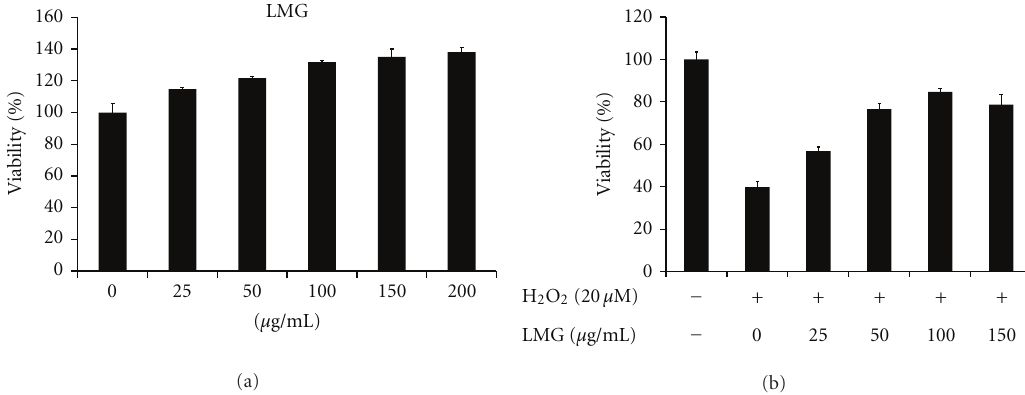
Figure 5: Protective abilities of LMG against H 2 O 2 -induced cytotoxicity in RAW264.7 cells. (a) MTT assay evaluated the cytotoxicity of LMG to RAW264.7 cells. Cells were treated with LMG (at 0, 25, 50, 100, 150, and 200 μ g/mL) for 24h. Results are presented as means ± SD for n = 5 replicates. (b) The protective ability of LMG from H 2 O 2 -induced cytotoxicity in RAW264.7 cells. Cells were cotreated with H 2 O 2 (20 μ M) and LMG (0, 25, 50, 100, and 150 μ g/mL) for 24h. Results are presented as the means ± SD for n = 5 replicates.